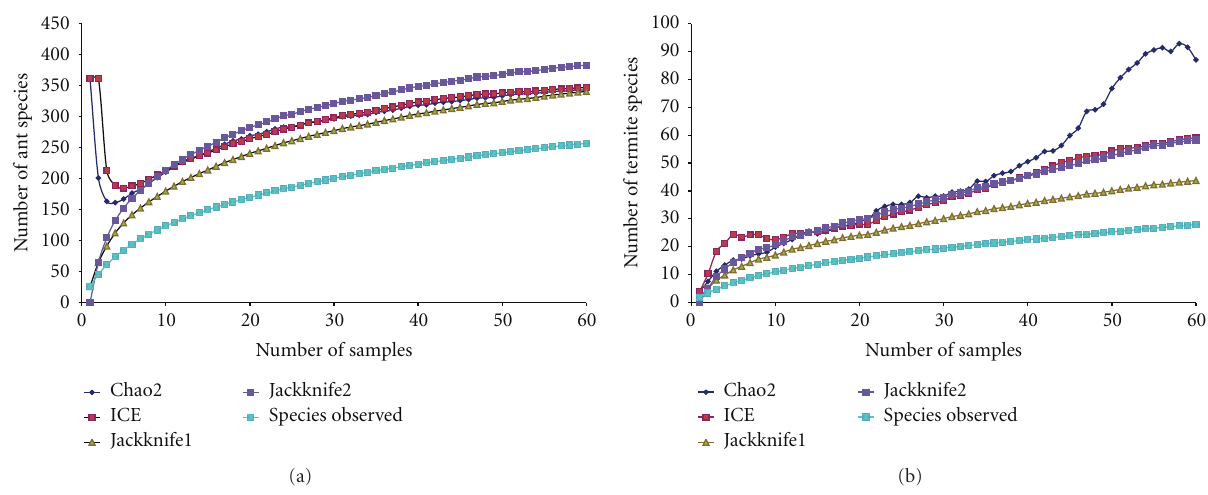
Figure 1: Species accumulation curves for (a) ants and (b) termites. Each sample consists of the total species collected via Winkler device, pitfall trap, baiting, and hand collecting at each sampling point ( n = 60). Values for nonparametric estimators ICE, Jack 1, Jack 2, and Chao 2 (classic) are also shown.